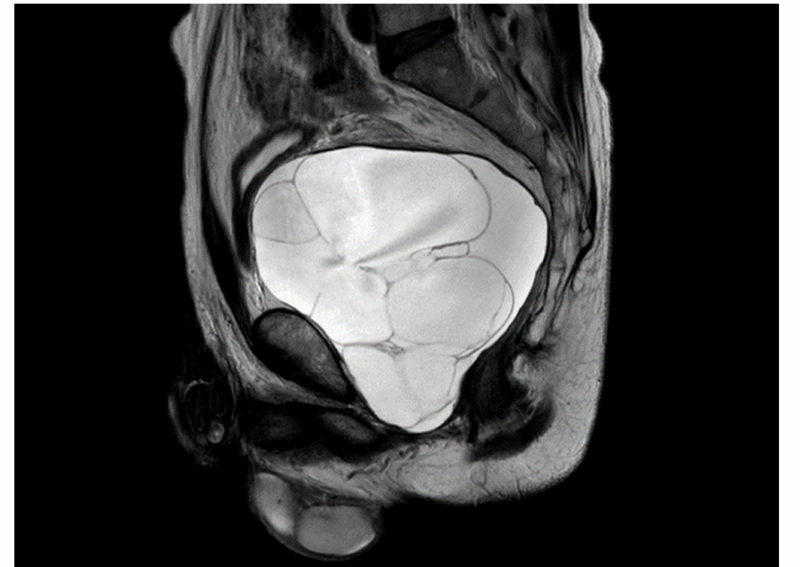
Figure 1. Prostate MRI showed a large cystic mass approximately 13 cm in size, multiple septa and lobulating contours in the prostate, and no visible solid lesions.